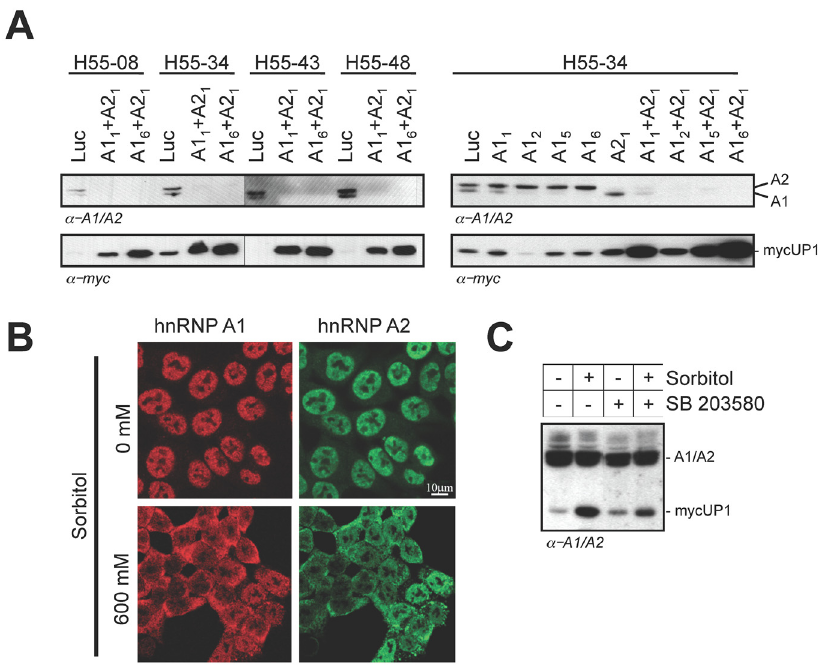
Fig 1. mycUP1 expression is stimulated by the depletion of nuclear of hnRNP A1 and A2. A , Western analysis of A1, A2 and mycUP1 from four selected HCT116 clones engineered to express a transfected myc- tagged mouse UP1. Stable transformants were transfected with various siRNA mixtures and proteins were extracted 72 hours later. Only siRNA A1 2 also targets the mouse mycUP1. B , Cytoplasmic accumulation of hnRNP A1 and hnRNP A2 in HCT116 cells upon osmotic shock. HCT116 cells growing on glass coverslips were left untreated (0 mM) or were exposed to 600 mM sorbitol. After 1 hour, cells were fixed and immunostained with anti-hnRNP A1 and anti-hnRNP A2 antibodies. C , Sorbitol stimulates mycUP1 expression in a p38 kinase-dependent manner. The p38 kinase inhibitor SB203580 was added to H55-34 cells for 2 hours (8 μ g/ml) before treating cells with 600 mM sorbitol for 1 hour. Cells were then washed with PBS and incubated in complete media for 24 hours. Endogenous A1/A2 and mycUP1 proteins were detected simultaneously using the anti-A1/A2